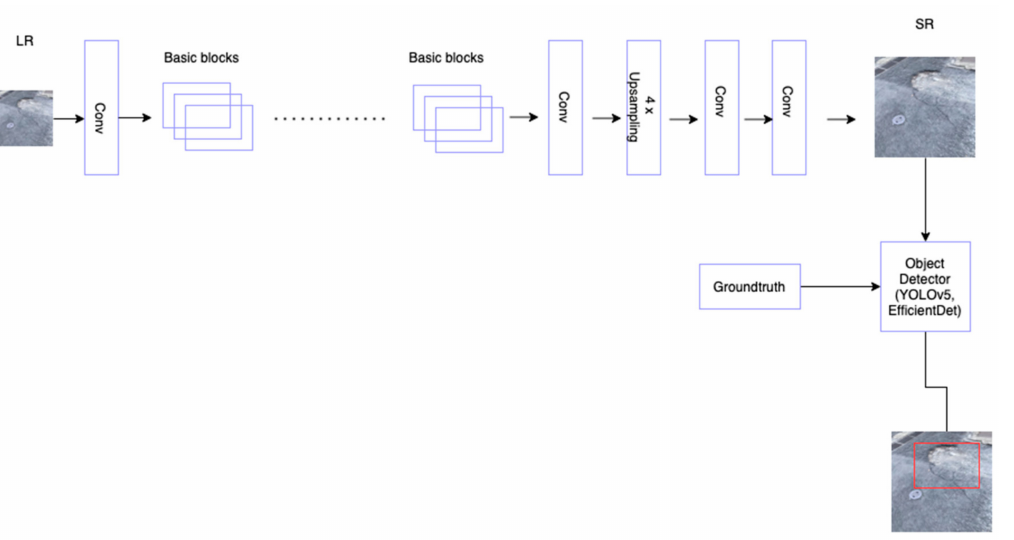
Figure 3. The proposed end-to-end architecture consisting of the ESRGAN super-resolution architec- ture and object